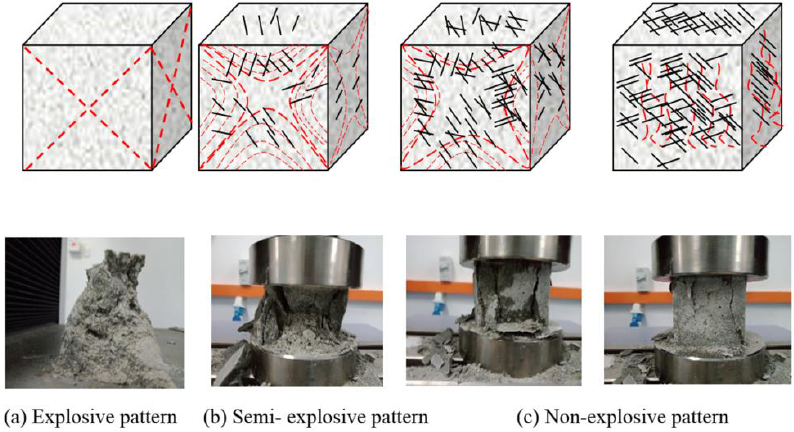
Figure 8. The efficiency of CSWFs with regard to the ability to bridge crack patterns. ( a ) Explosive pattern; ( b ) Semi-explosive pattern; ( c ) Non-explosive pattern.